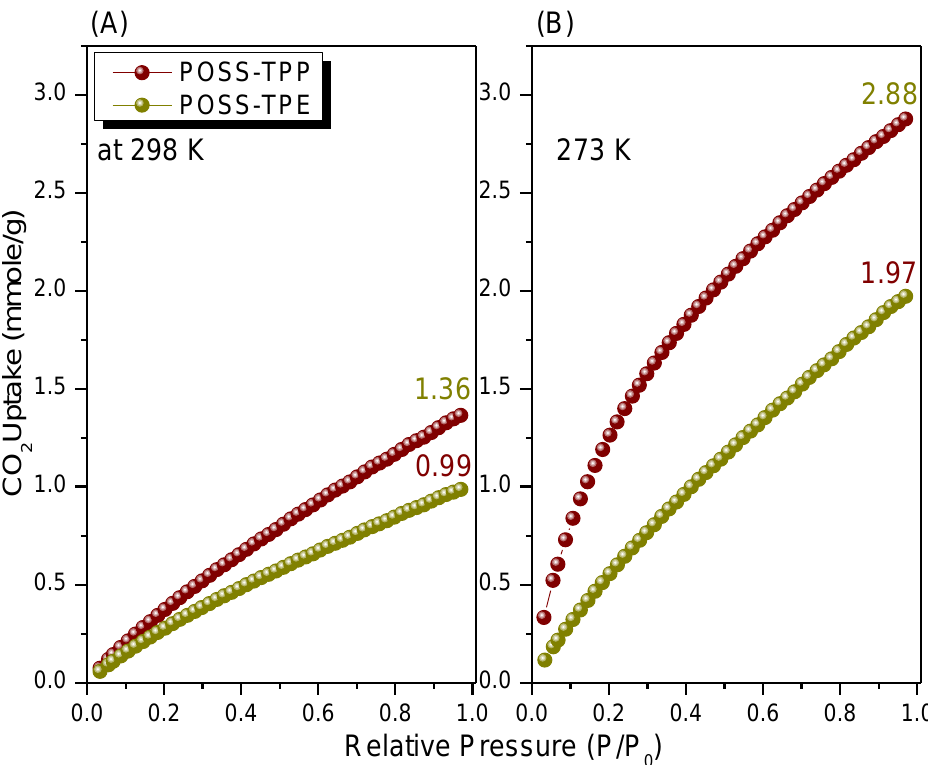
Figure 8. CO 2 uptake profiles of ( A ) POSS-TPP and ( B ) POSS-TPE. The developing porous polymer absorbents featuring good porosities and unique structures to decrease environmental pollution, such as I 2 , have attracted much intention in both academics and industry [19]. As reported by different groups, the performance of the porous organic polymers as adsorbents for iodine uptake strongly depends on the interaction of the iodine molecule with the polymer framework and does not depend on the pore size or volume of the polymer network [19]. Figure 9A,B presents the UV absorbance spectra of the suspension solutions of the POSS-TPP and POSS-TPE in ethanol with an I 2 solution (10 − 4 M) at different interval times (0 h to 24 h). As shown in Figure 9A,B, the maximum intensity of the adsorption peak of I 2 was detected at λ max = 523 nm. After the addition of 5 mg of POSS-TPP or POSS-TPE into the iodine solution in hexane, the intensity of the absorption bands of the I 2 gradually decreased when the time increased from 0 to 24 h. These results suggest that both POSS-TPP and POSS-TPE could act as good precursors for I 2 adsoprtion. The calibration curve (Figure 9C) of the iodine was measured through the recording of UV-Vis spectra of different I 2 concentrations in hexane. We observed that the maximum adsorption capability value (Figure 9D) of the POSS-TPP (363 mg/g) was higher than that of POSS-TPP (309 mg/g). From the adsoprtion experiments, the POSS-TPP was considered a better adsorbent material for iodine than POSS-TPE due to the presence of N-atoms in the POSS-TPP framework, leading to strong interaction with the I 2 molecules. POSS-TPP and POSS-TPE showed excellent iodine uptake performance compared with other POP adsorbents, as presented in Table S2. In addition, the synthesis of hybrid porous organic polymers based on the POSS unit through a simple Friedel–Crafts reaction with large-scale applications was considered as an effective synthetic method [36]. For recycling experiments, the iodine-loaded POSS-TPP and POSS-TPE samples were washed with ethanol to remove the I 2 molecules and dried at 100 °C. As shown in Figure S6, after recycling the measurements six times, the iodine capture capacities of the POSS-TPP and POSS-TPE were found to drop from 363 mg/g to 362 mg/g and 309